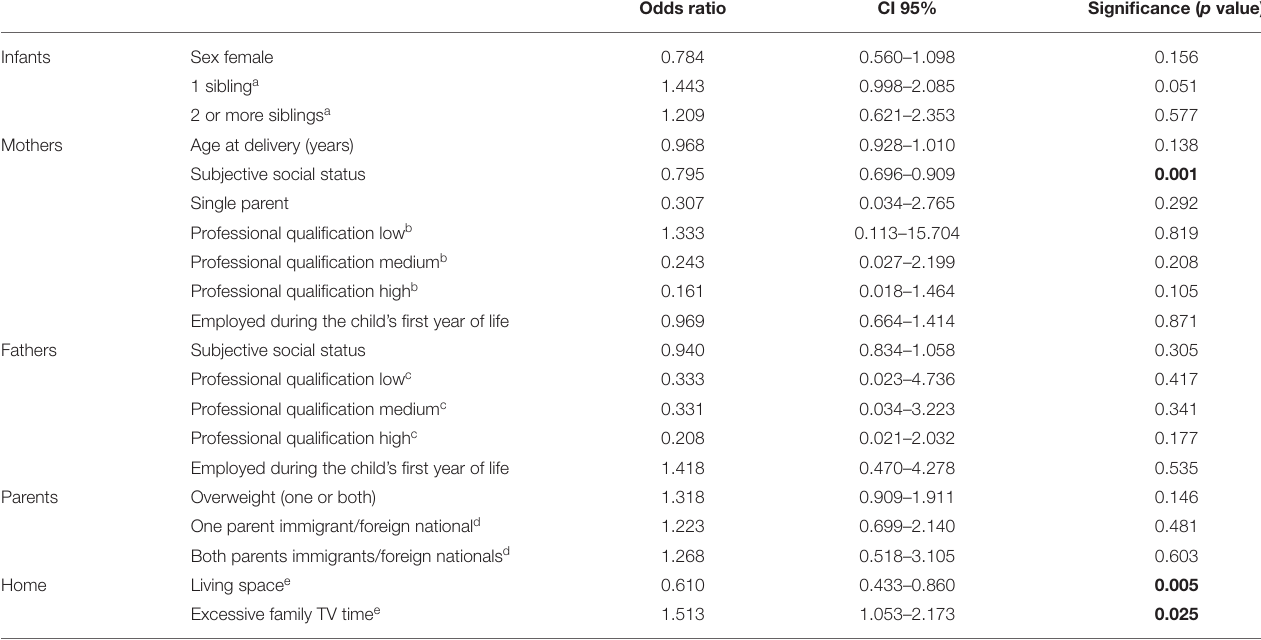
TABLE 3 | Univariable logistic regression analysis of possible predictors and infant screen time. Odds ratio CI 95% Significance ( p value)